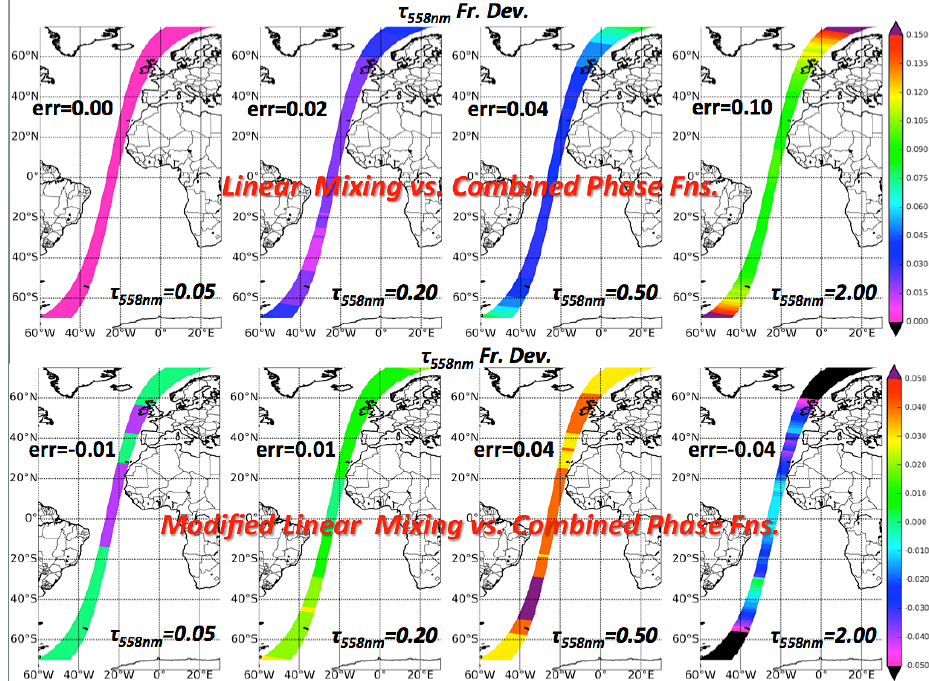
Figure 7. Modified linear mixing (MLM) sensitivity study, showing the fractional change in retrieved AOD for a two-aerosol-component atmosphere containing spherical particles having r e = 1.28 and 0.06 micron, 50% mid-visible AOD each. The top four panels show the fractional retrieved-AOD change when both components are non-absorbing and a linear mixing approximation is used to combine the particles rather than creating layer-effective phase functions according to Eq. (3). The bottom four panels show the fractional change in retrieved AOD when the MLM approximation is used to combine a 1.28 micron non-absorbing particle with a 0.06 micron absorbing particle, having SSA = 0.80 at a wavelength of 558nm, rather than using layer-effective phase functions. For both sets of panels, the total-column AOD values at 558nm are 0.05, 0.20, 0.50, and 2.0, progressing from left to right. The orbit-mean AOD error (err) is indicated in each panel. As values vary with retrieval geometry, these forward model results are plotted for an illustrative orbit, orbit 70499, 20 March 2013. Over- water conditions are assumed everywhere, with the surface pressure prescribed as 1013.25mb, and the surface wind speed set to 2.5ms − 1 . A more extensive analysis of the impact of linear mixing and MLM on retrieved AOD is given in the